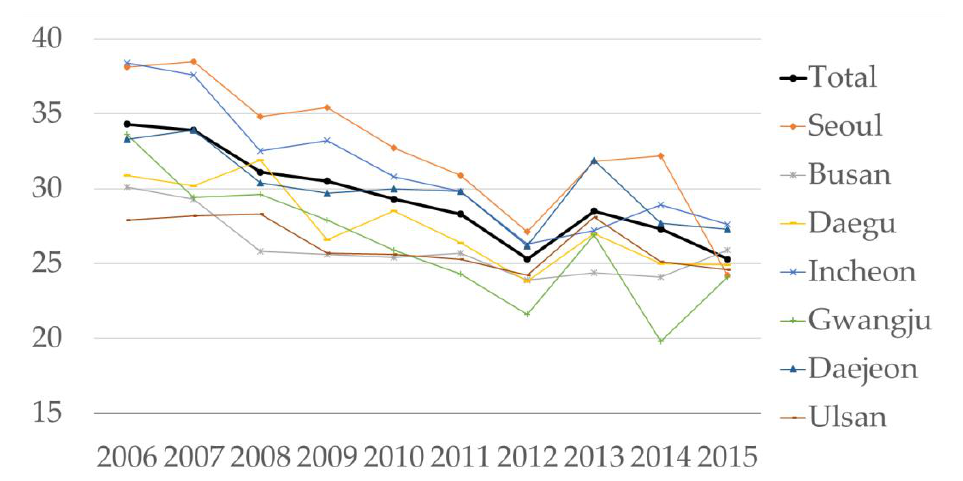
Figure 2. Mean concentration of PM 2.5 by year and metropolitan city.